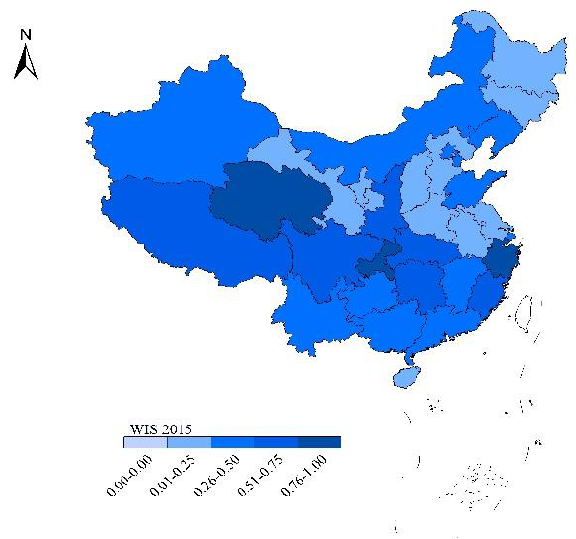
Figure 5. Spatial distribution map of WSI in 2015.